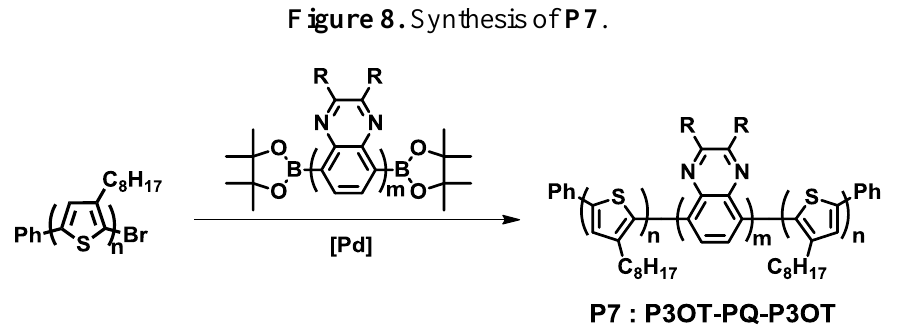
Figure 8. Synthesis of P7 .